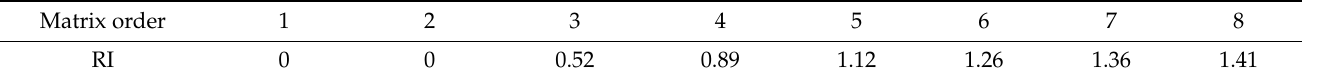
Table 5. The average random consistency index.